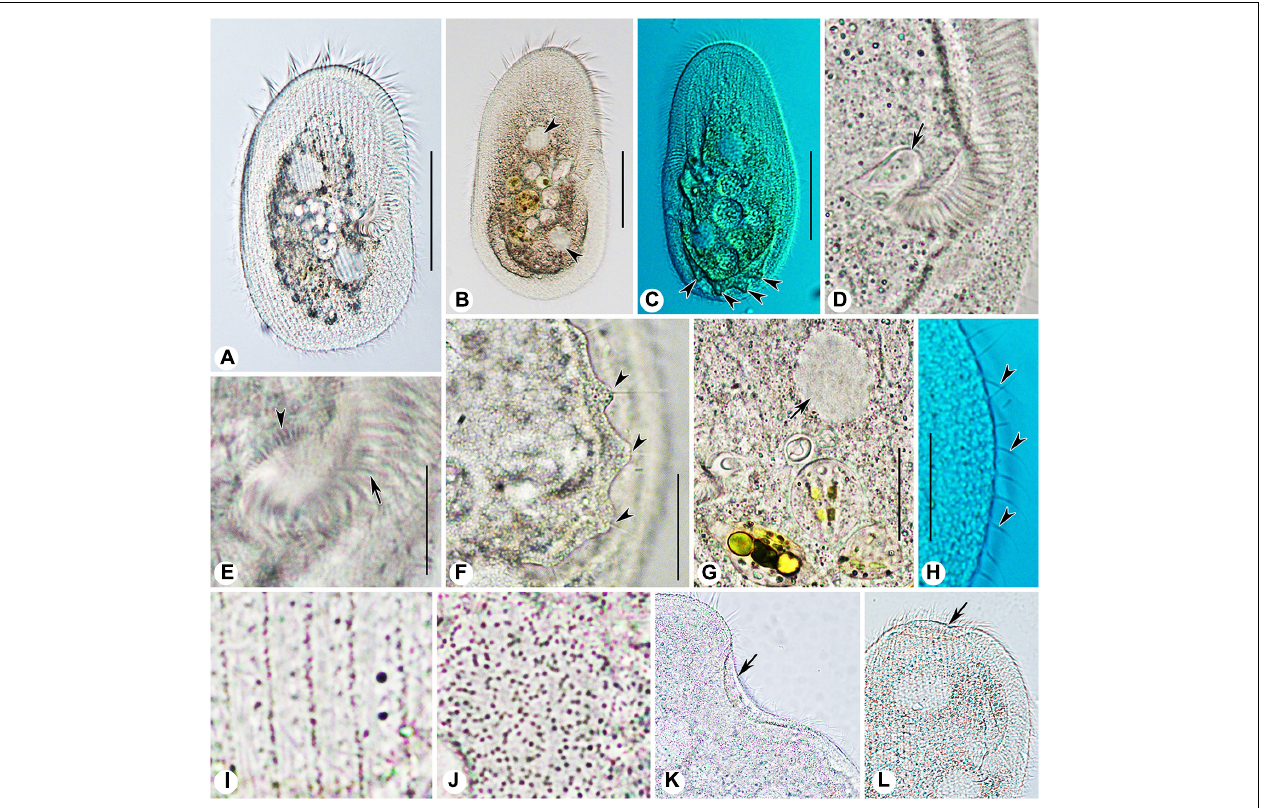
FIGURE 5 | Photomicrographs of Peritromus kahli (A , C–J) population-I and (B,K,L) population-II from life. (A , B) Ventral view of two typical individuals; arrowheads indicate macronuclear nodules. (C) Dorsal view of an individual; arrowheads indicate wart-like prominences (papillae). (D) Detail of oral area; arrow indicates cytostome. (E) Enlargement of the oral area; arrow indicates adoral zone of membranelles, and arrowhead indicates fiber bundles. (F) Dorsal view of wart-like prominences (papillae) from which spine-like cilia (dorsal bristles) emerge (arrowheads). (G) To show a macronuclear nodule (arrow). (H) To show the cilia of external dorsal kinetids (arrowheads) distributed along the edge of the cell. (I) Ventral view, to show the type I cortical granules. (J) Dorsal view, to show the type II cortical granules. (K , L) To show folded part of cell (arrows). Scale bars = 50 µ m (A–C) , 15 µ m (E–H)